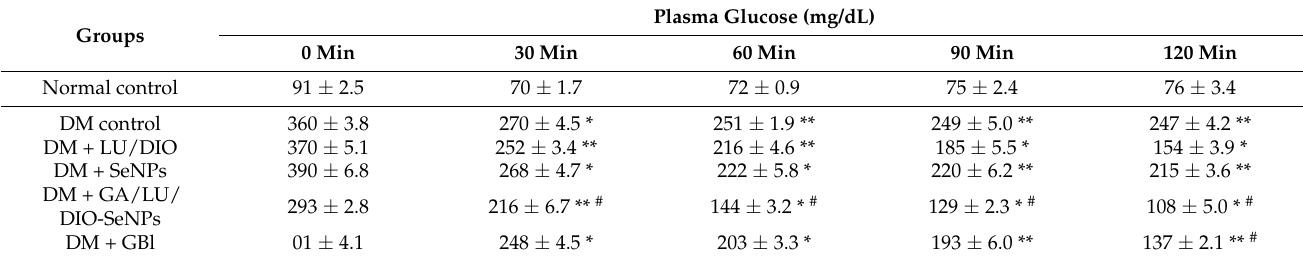
Table 5. Effect of LU/DIO, SeNPs GA/LU/DIO-SeNPs on insulin tolerance test (ITT) in diabetic